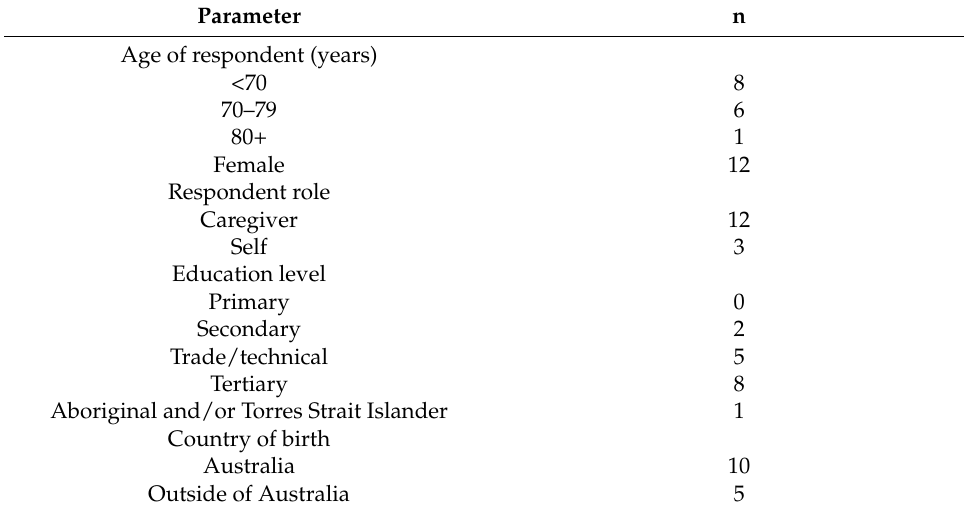
Table 1. Respondent